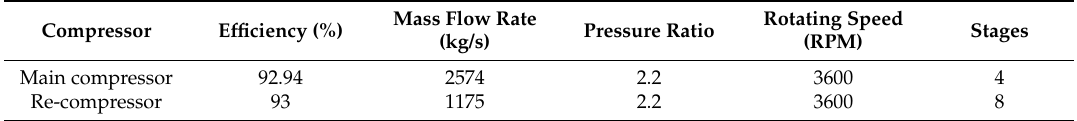
Table 1. 300 MWe axial-flow SCO 2 compressor (Yong Wang).